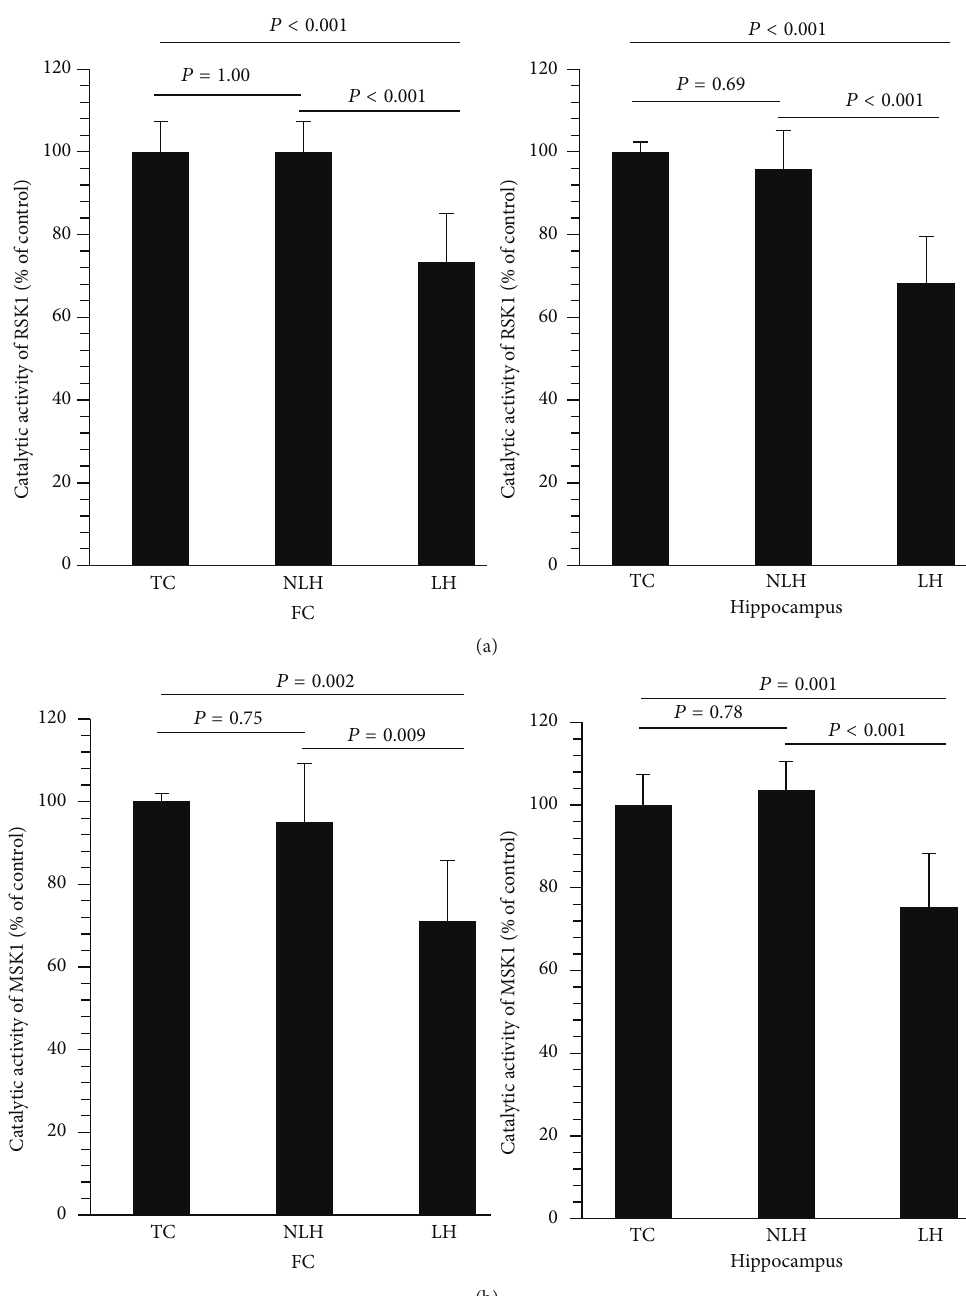
Figure 8: Catalytic activates of RSK1 and MSK1 in frontal cortex (FC) (a) and hippocampus (b) of tested control (TC), non-learned helpless (non-LH), and learned helpless (LH) rats. Overall group differences are as follows. RSK1: FC, df = 2,15 , 𝐹 = 17.21 , and 𝑃 < 0.001 ; hippocampus, df = 2, 15 , 𝐹 = 24.38 , and 𝑃 < 0.001 . MSK1: FC, df = 2,15 , 𝐹 = 10.21 , and 𝑃 < 0.002 ; hippocampus, df = 2, 15 , 𝐹 = 15.75 , and 𝑃 = 0.12